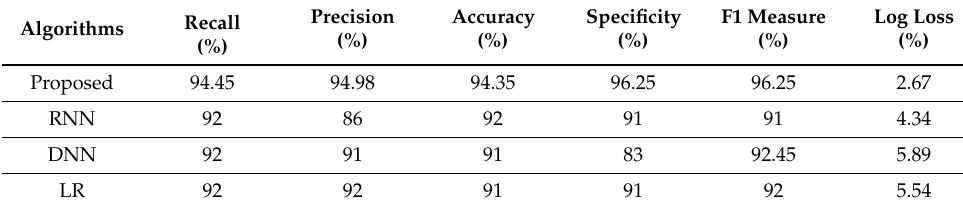
Table 5. Attack Classification Analysis: Query Flood Attack.